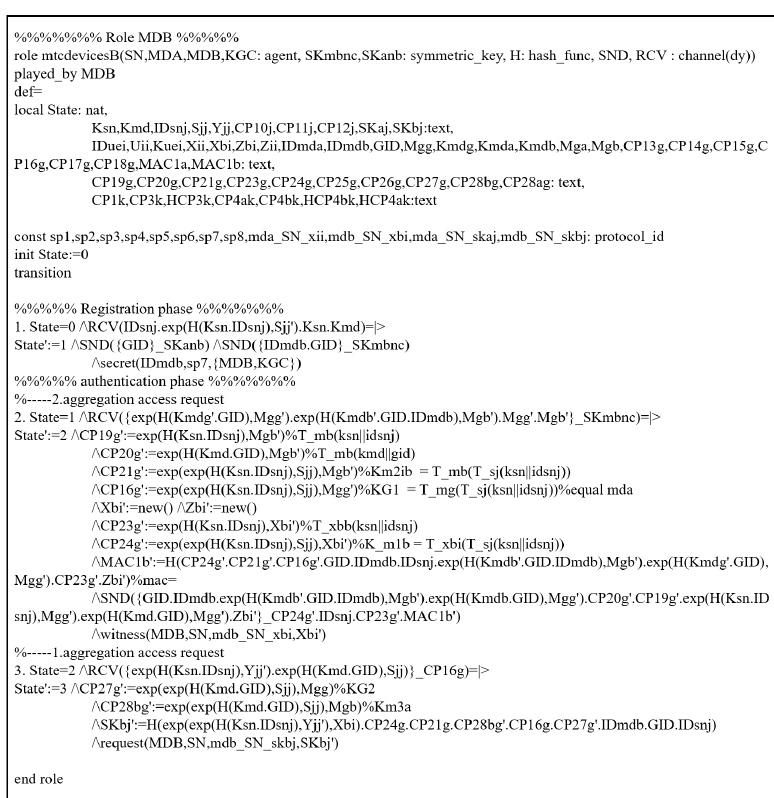
Figure 8. Scenario 2: HLPSL description of MD i role.